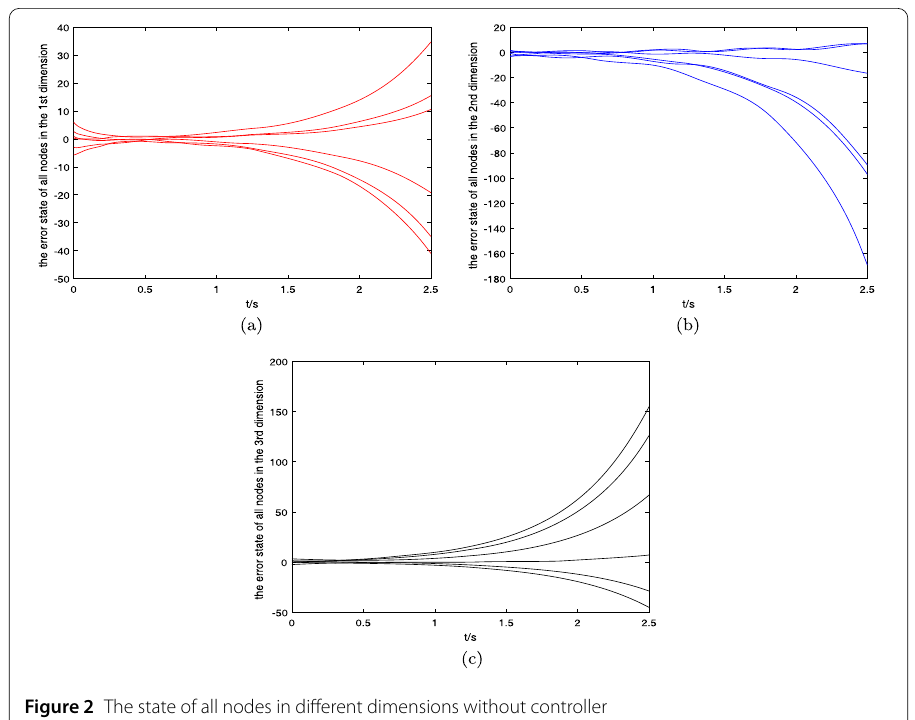
Figure 2 The state of all nodes in different dimensions without controller